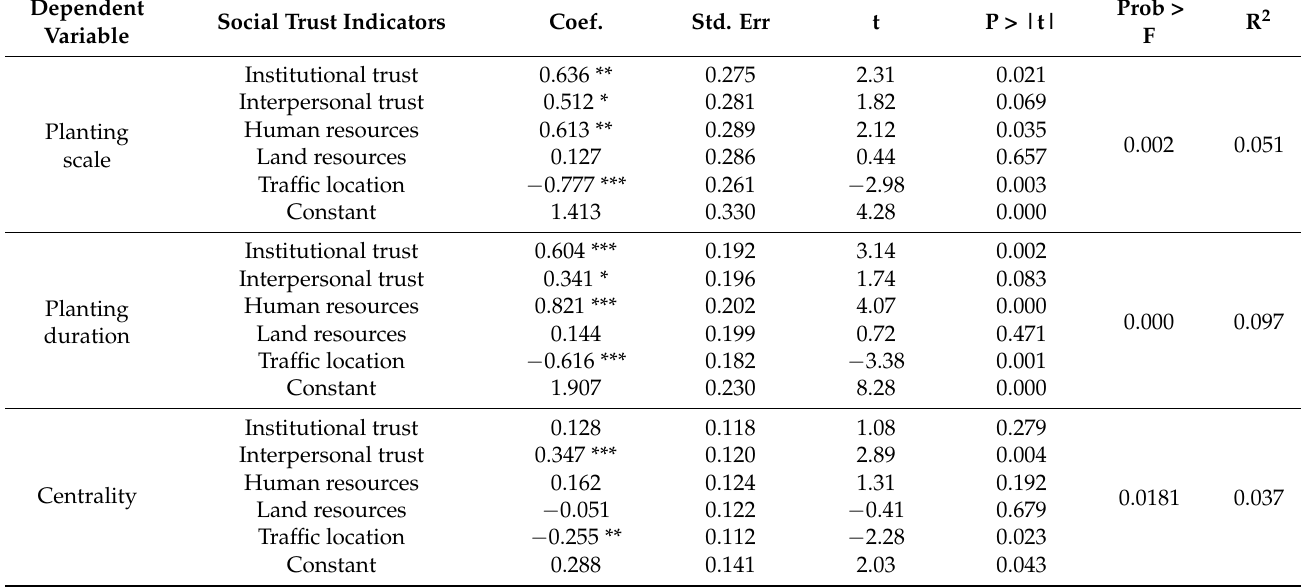
Table 5. Impact of social trust on grape planting in